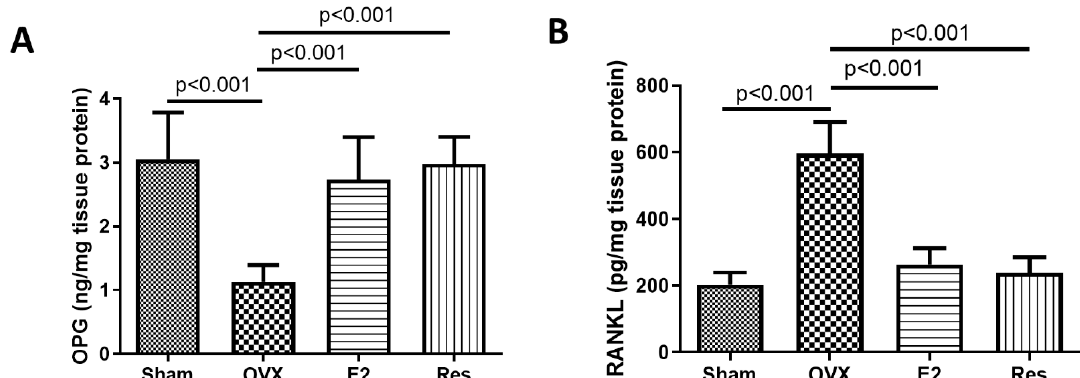
Figure 3. Resveratrol and E2 significantly increased OPG and decreased RANKL aortic levels. The protein levels of ( A ) OPG and ( B ) RANKL. Protein levels were quantified using ELISA. OVX: ovariectomized rats; E2: estradiol; Res: resveratrol. Graphs show mean ± SD, n = 6.